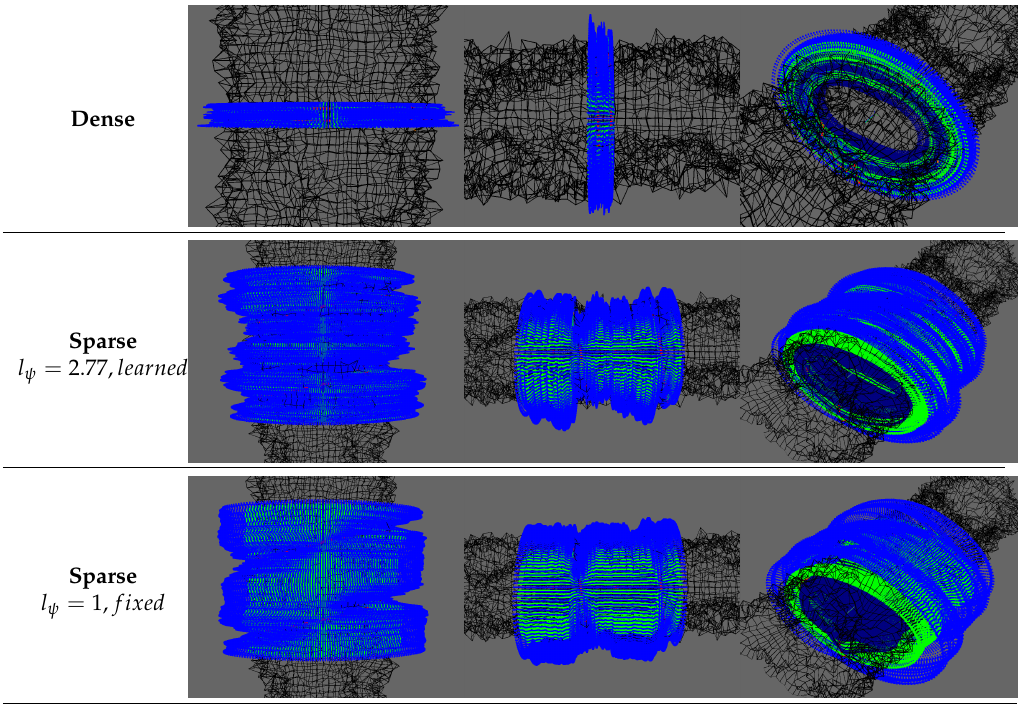
Figure 15. Surface estimation for a chaotic